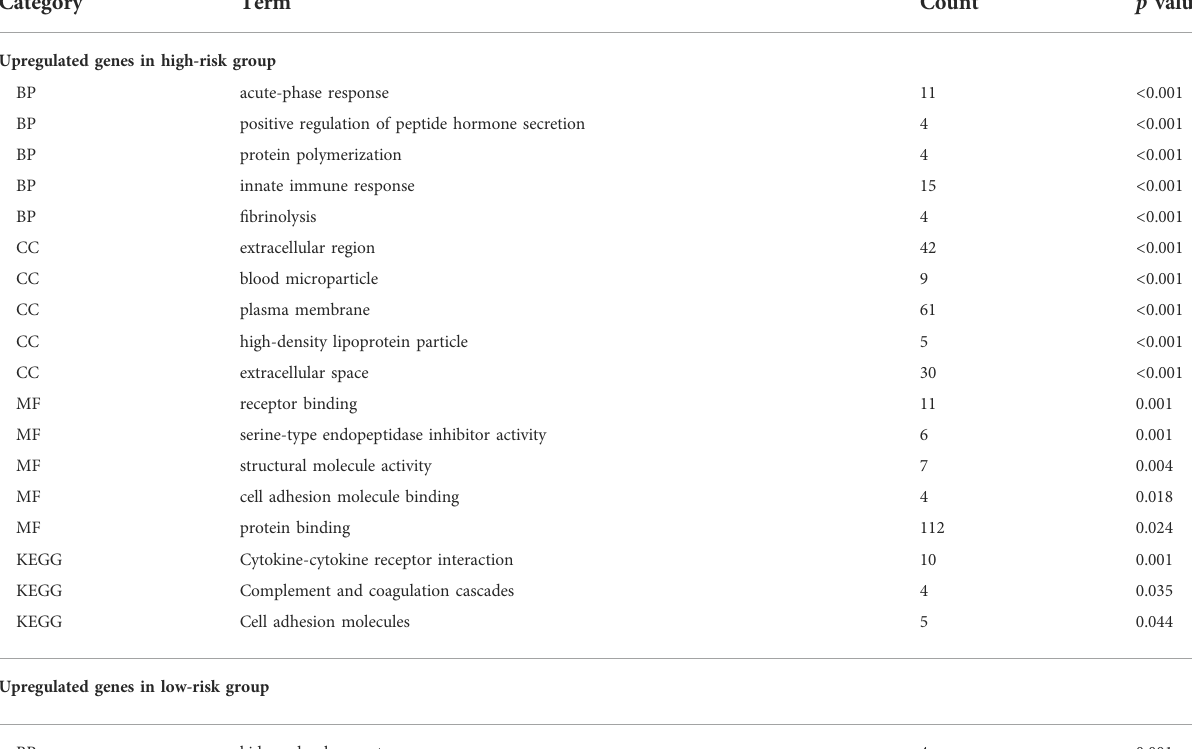
TABLE 2 GO and KEGG analysis of DEGs between low- and high-risk